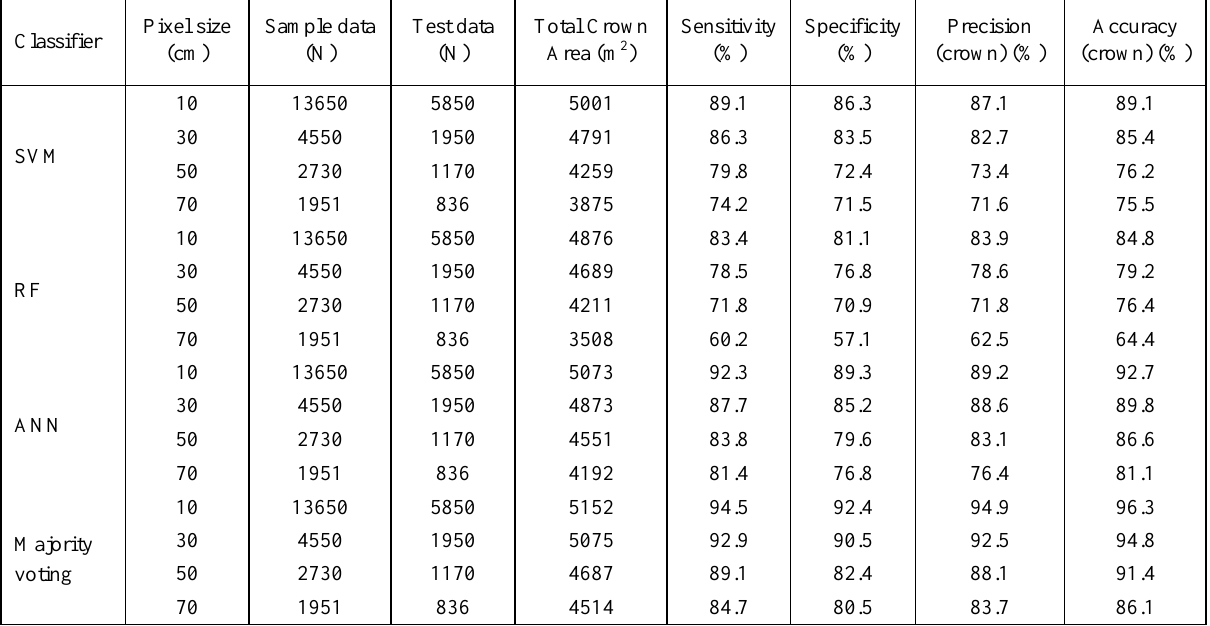
Table 3. Statistical summary of the crown area estimated on UAV orthoimagery with different pixel